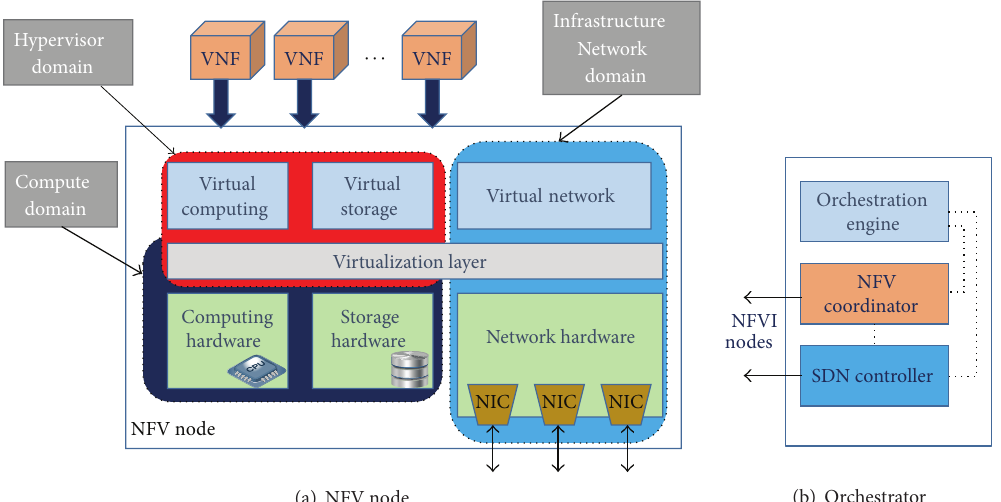
Figure 1: Network function virtualization infrastructure.